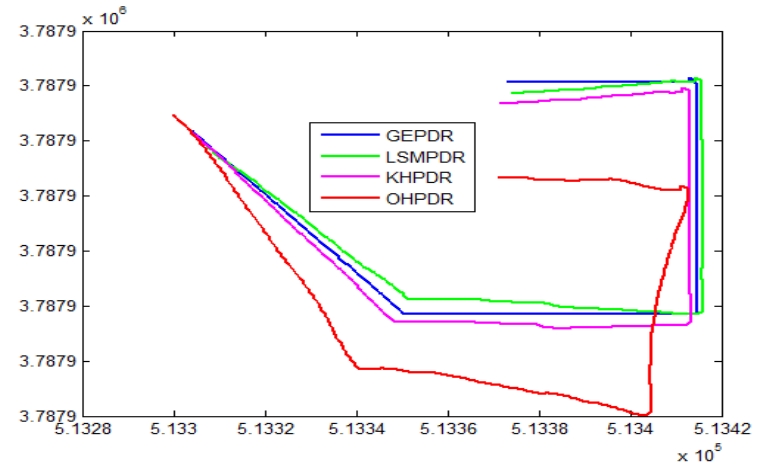
Figure 9. Positioning trajectory analysis for different solutions associated with PDR .